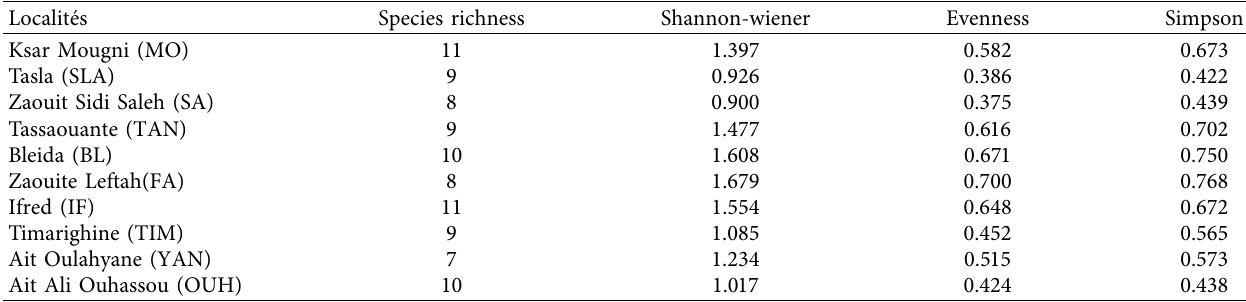
Table 1: Species richness, Shannon–Wiener diversity index (H), evenness (E), Simpson’s diversity index (D) in studied villages. Localit´es